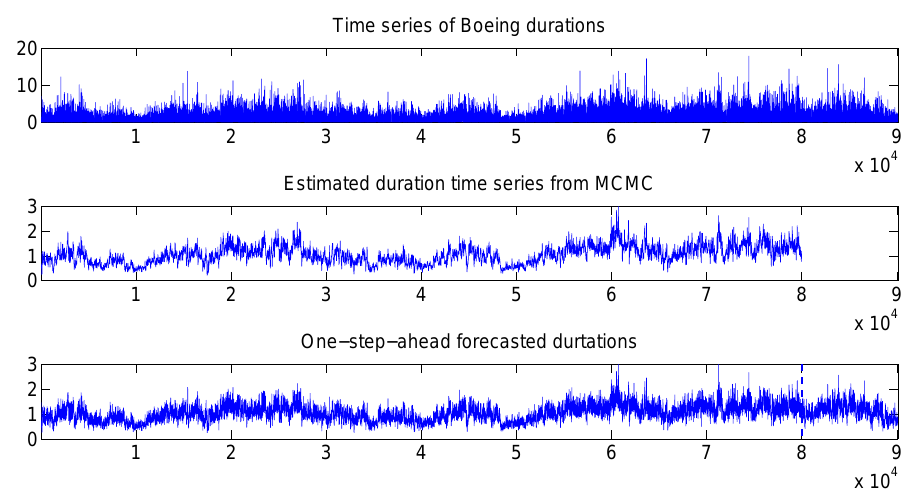
Figure 9. Comparison between observed durations, estimated, and one-step-ahead forecasted conditional durations based on the TSCD-W model using the Boeing stock transaction data.